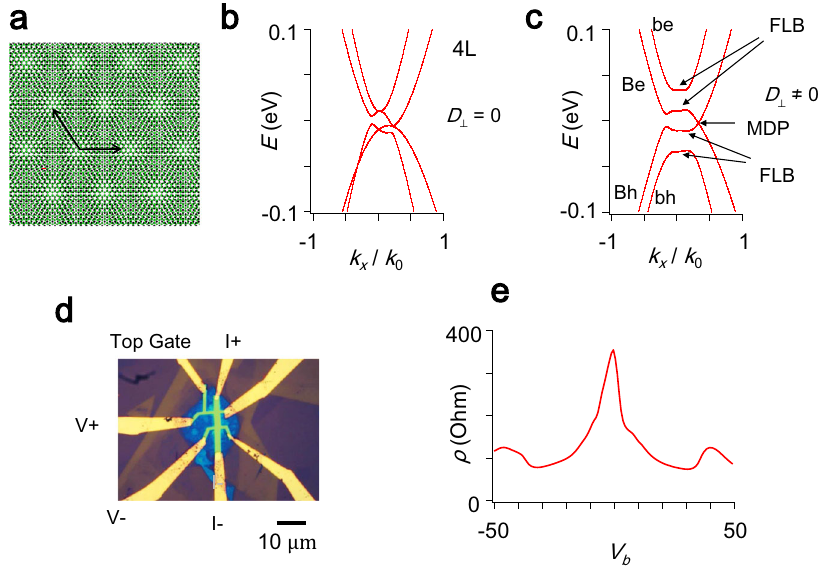
Fig. 1 Sample characterization. a Schematic drawing of moiré structure formed by stacking two honeycomb lattice sheets. The arrows indicate the periodic structure. b Low energy dispersion relation of AB-stacked tetralayer graphene in the absence a perpendicular electric fl ux density, calculated for ( a is the lattice constant of graphene). c Low energy dispersion of AB-stacked Slonczewski-Weiss-McClure (SWMcC) parameters of graphite. k 0 ¼ 2 γ 1 p 3 γ 0 a tetralayer graphene in the presence a perpendicular electric fl ux density. FLB stands for the nearly fl at part in the band. Be (Bh) is an electron-like (hole- like) heavy mass bilayer-like band; be (bh) is an electron-like (hole-like) light mass bilayer-like band. d Optical micrograph of a sample. Hall bar equipped with top and bottom gate electrodes. The bar is 10 μ m long. e Bottom gate voltage ( V b ) dependence of resistivity ( ρ ) measured for zero top gate voltage ( V t = 0 V). T ¼ 4 : 2Kand B ¼ 0T : The peak for charge neutrality ( V b (cid:2) 0V) and satellite peaks ( V b (cid:2) 40and (cid:3) 45V) are